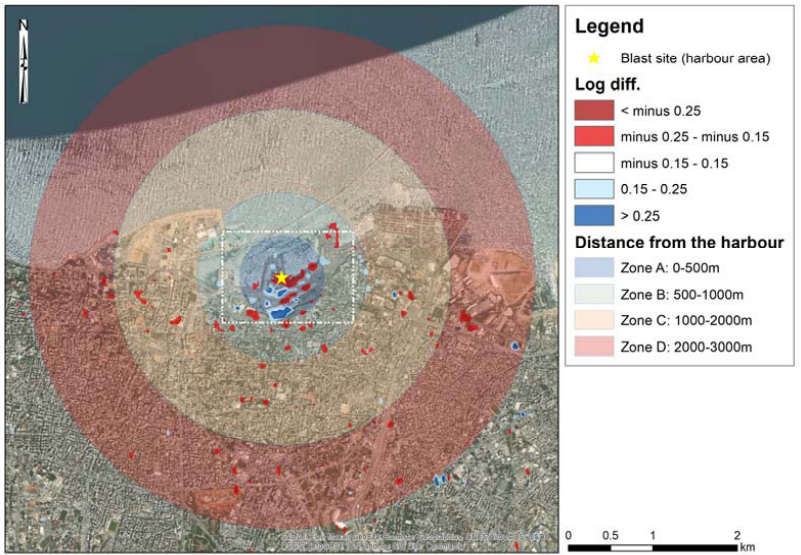
Figure A1. Change detection results using the log difference of the VH backscattering amplitude. Significant changes of the pair of images are presented with dark red and blue colors (> − 0.25 or >0.25 differences), while other minor changes in the range of − 0.25 to − 0.15 and 0.15 to 0.25 are also presented in light red and blue colors, respectively. The four zones under study (Zone A to Zone D) are also given. The location of the blast size is shown with the yellow star. The white dashed rectangle around the blast site is indicating the zoomed ‐ in area presented in Figure A3.